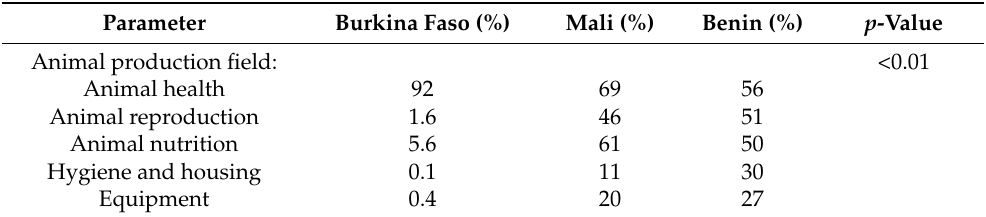
Table 4. Animal production fields in which farmers in Burkina Faso, Mali, and Benin were willing to pay for extension and training